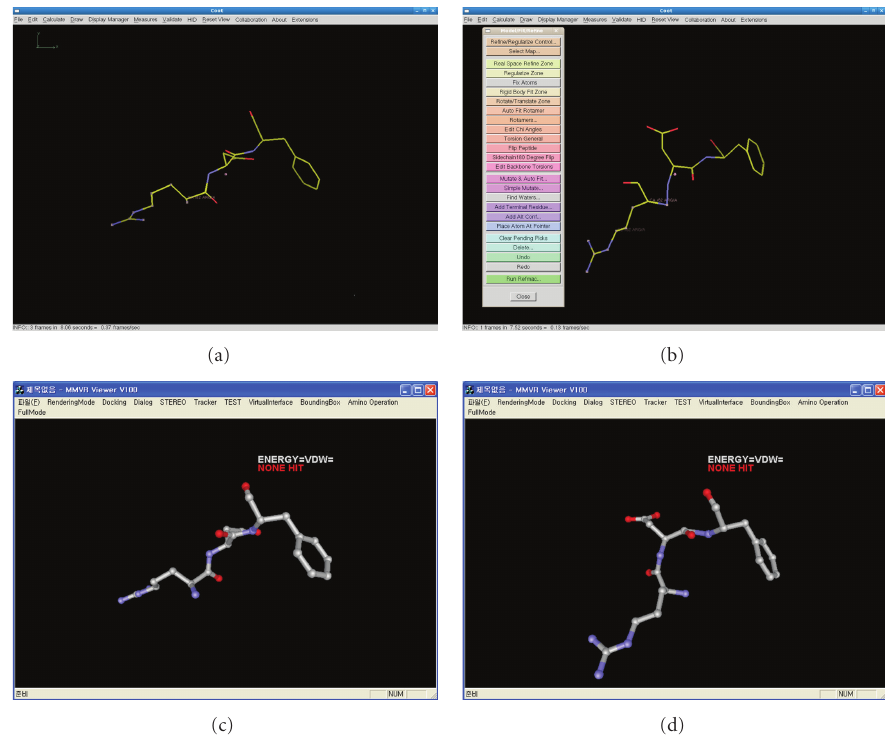
Figure 4: Results of editing operations: (a) an original model on Co-Coot, (b) a changed model on Co-Coot, (c) the original model on VRMMS, and (d) the changed model on VRMMS.